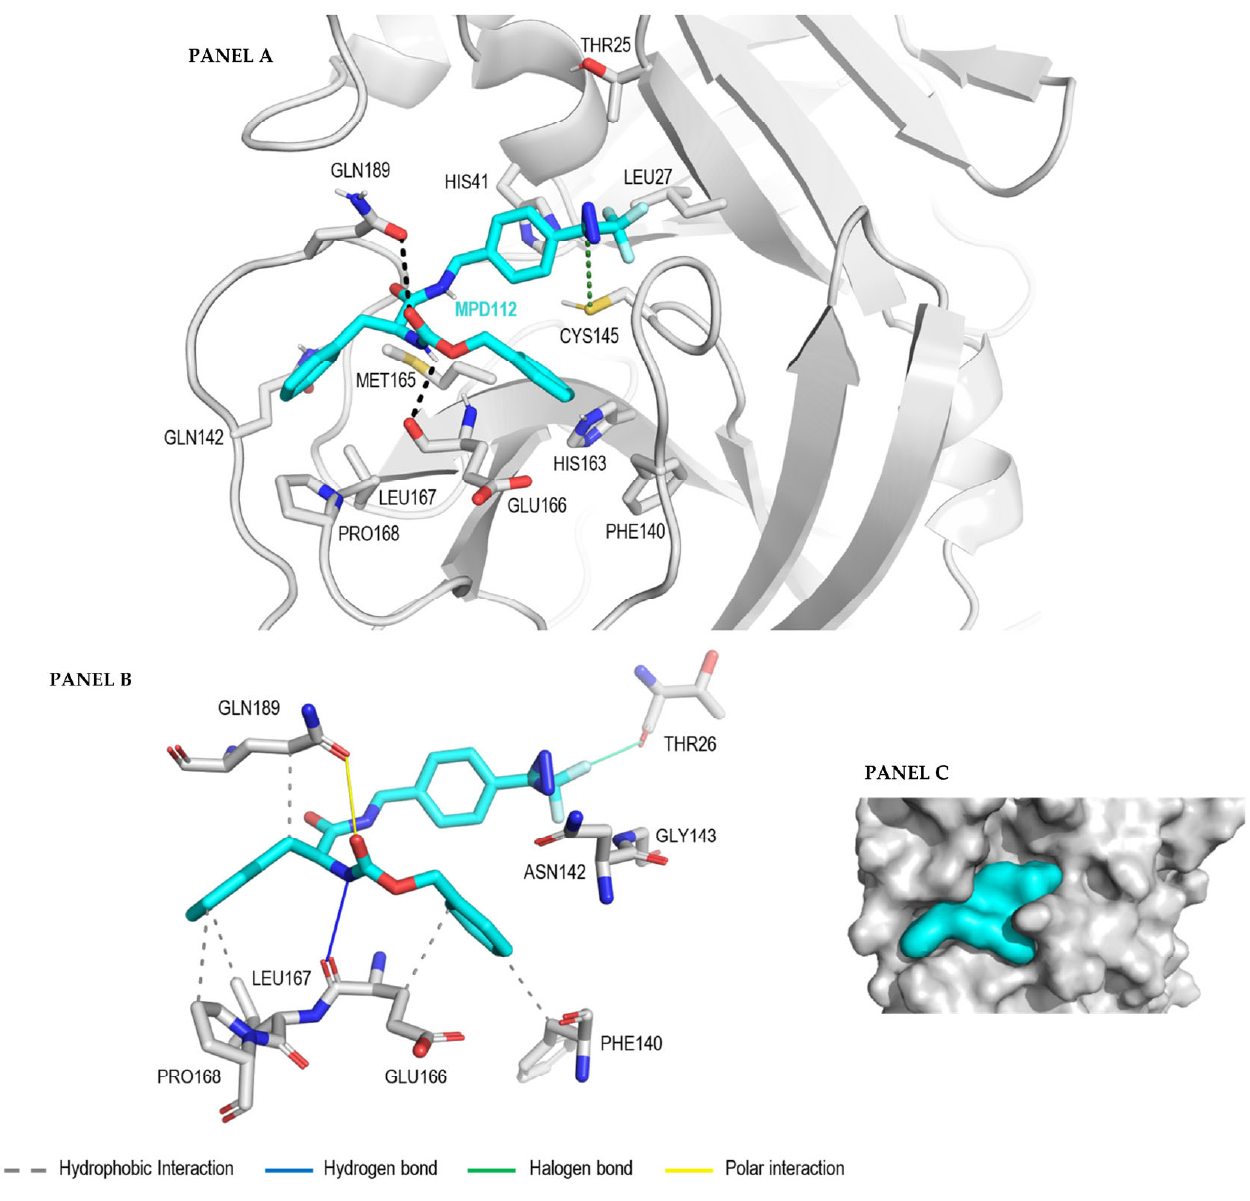
Figure 3. Best binding mode of MPD112 obtained by Autodock Vina when bound to the active site of the M pro of SARS-CoV-2 (PDB: 7NG3) shown in sticks mode (panel A ), the protein–ligand interaction profile of the complex (panel B ) and its representation in surface mode (panel C ).